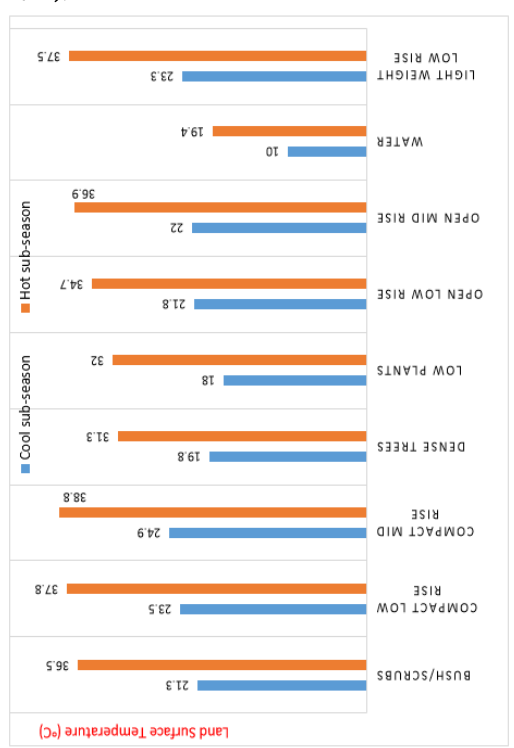
Figure 3: Land surface temperature at coincident time with LCZ map (a) in the cool and (b) the hot season